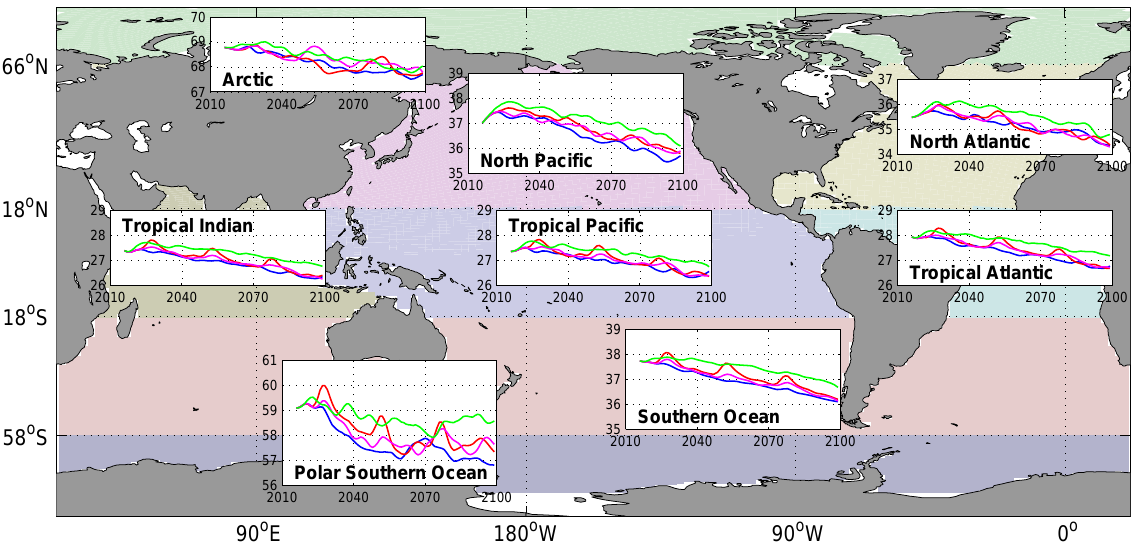
Fig. 8. Regional evolution of CO 2 gas solubility in seawater from 2020 to 2099 period. Plotted here are the five-year running means from (blue-lines) REF, (red-lines) GEO TAM25, (magenta-lines) GEO PIN25, and (green-lines) GEO PIN5 experiments. Units are in [mmoll − 1 ppm − 1 ]. Regions are defined as follow: Arctic ( > 66 ◦ N), North Atlantic (18 ◦ N–66 ◦ N), North Pacific (18 ◦ N–66 ◦ N), Tropical Atlantic (18 ◦ S–18 ◦ N), Tropical Pacific (18 ◦ S–18 ◦ N), Tropical Indian (18 ◦ S–25 ◦ N), mid latitude Southern Ocean (58 ◦ S–18 ◦ S), high latitude Southern Ocean ( > 58 ◦